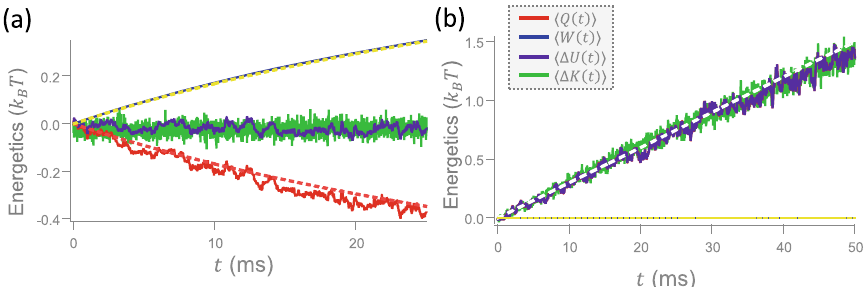
Figure 4. The cumulative sums of various energetic quantities during (a) an iso- T compression, where 25 ms at T eff 300 K, and (b) an iso- k k eff increases linearly from 10 pN/ µ m to 20 pN/ µ m within τ = = 50 ms at k eff 20 pN/ µ m. In (a), the expansion, where T eff increases linearly from 300 K to 1200 K within τ = = � U ( t ) � K ( t ) Q ( t ) W ( t ) experimentally attained (red zigzag), (blue zigzag), (purple zigzag), and (green (cid:31) (cid:30) (cid:31) (cid:30) (cid:31) (cid:30) (cid:31) (cid:30) Q ( t ) W ( t ) zigzag) are compared with the theoretically derived (magenta smooth dashed) and (yellow smooth (cid:31) (cid:30) (cid:31) (cid:30) dashed). In this scale, the fluctuation of the blue zigzag line is so small that it looks identical with the yellow smooth dashed line. In (b), the meanings of different lines are the same as those in (a), except for the white dashed line, which replaces the magenta dashed line. Notably, the red line in this plot is hidden under the purple line. All experimentally extracted lines have been averaged over an ensemble of 10 4 stochastic trajectories. For � K ( t ) 100 µ s. the calculation of , the sampling time for evaluating the velocity is t s = (cid:31) (cid:30)